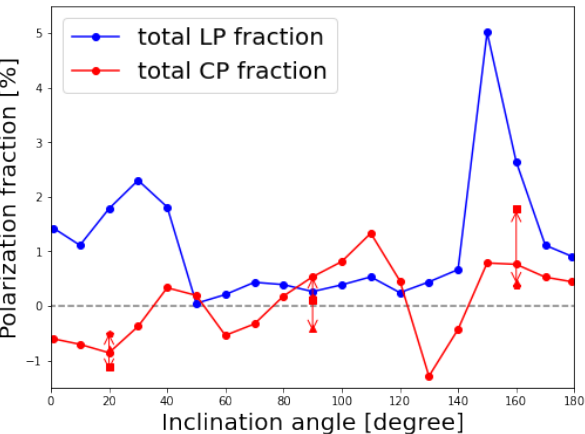
Figure 4. Diagram of the total LP and CP fractions at 230 GHz for different inclination angles. For i = 20 ◦ ,90 ◦ , and 160 ◦ cases, we additionally plotted the values for other three snapshots in the GRMHD model. t = 9500 t g (triangle), 10,000 t g (square), and 11,000 t g (pentagon), whereas t = 9000 t g (circle) for the fiducial model. The arrows indicate the time variations of the CP